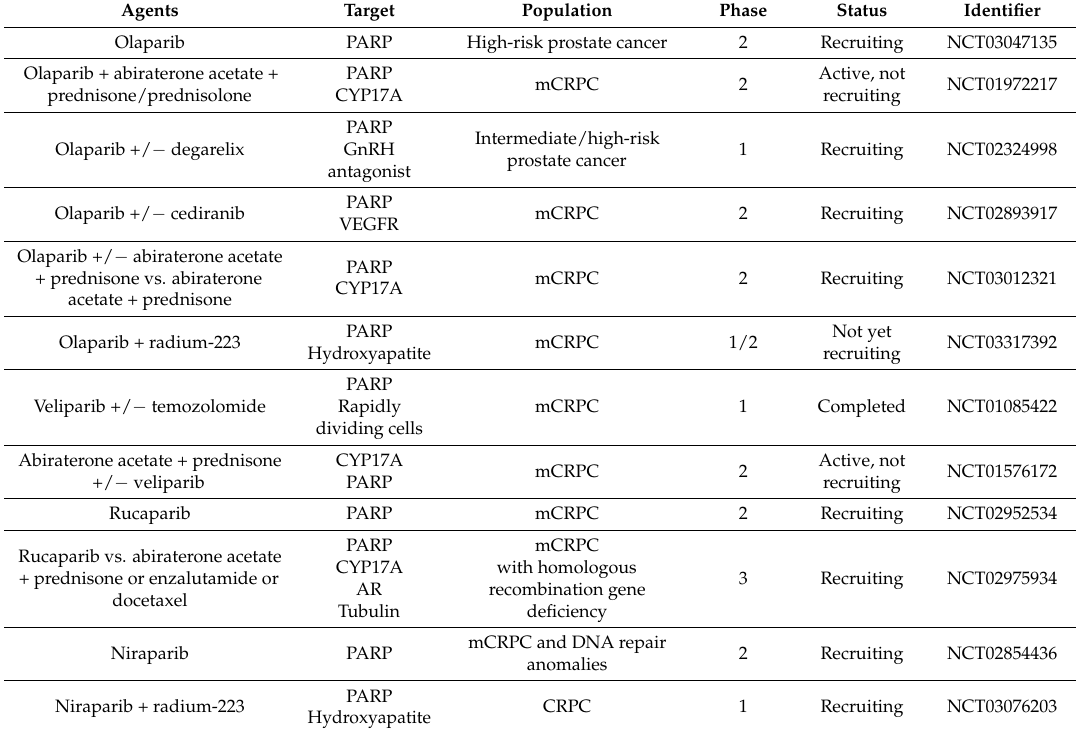
Table 3. Selected clinical studies focusing on prostate cancer with drugs targeting PARP. Source: